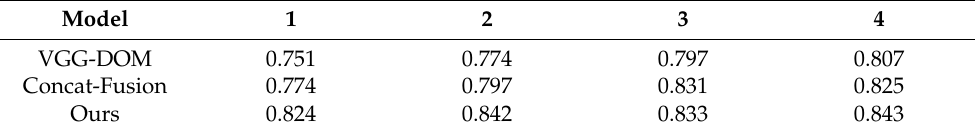
Table 4. Detection performance (F1-score) using different numbers of training